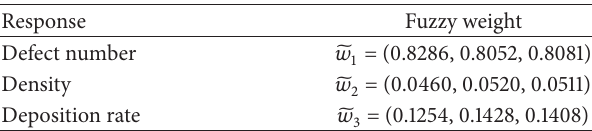
Table 2: Fuzzy weights for each quality response.